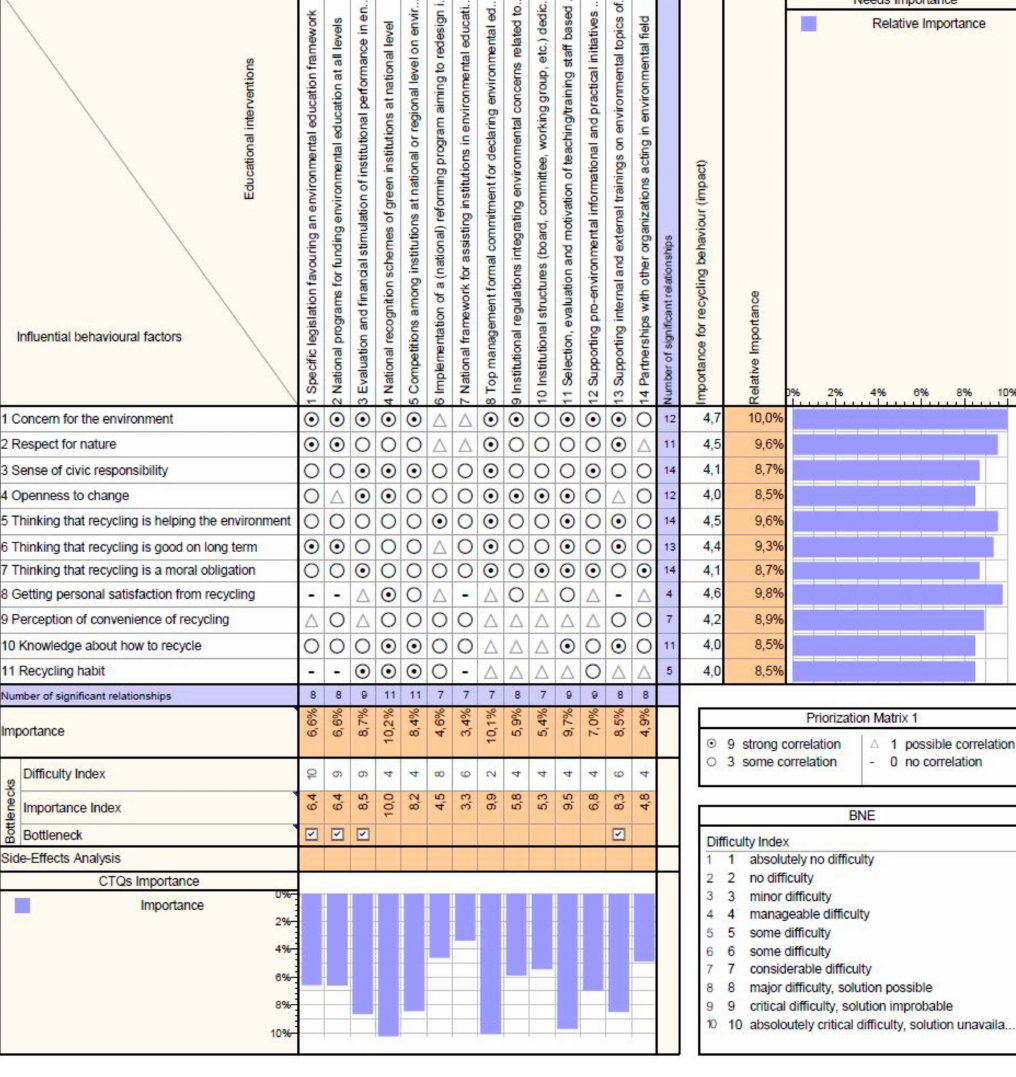
Figure 5. Correlation Matrix for interventions at national and institutional level—output from the Qualica QFD